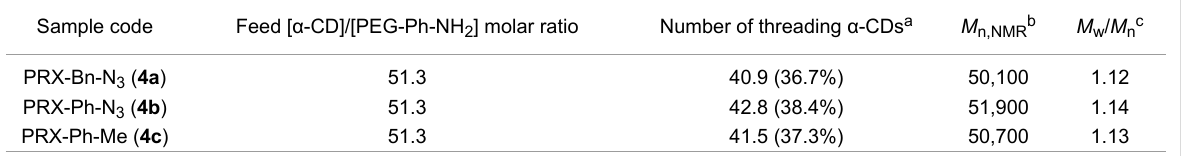
a Determined by 1 H NMR in NaOD/D 2 O. The values in parentheses denote the percentage of α -CD coverage on the PEG chain, assuming one α -CD molecule includes two repeating units of ethylene glycol. b Calculated based on the chemical composition of the PRXs determined by 1 H NMR. c Determined by SEC in DMSO containing 10 mM LiBr at 65 °C.